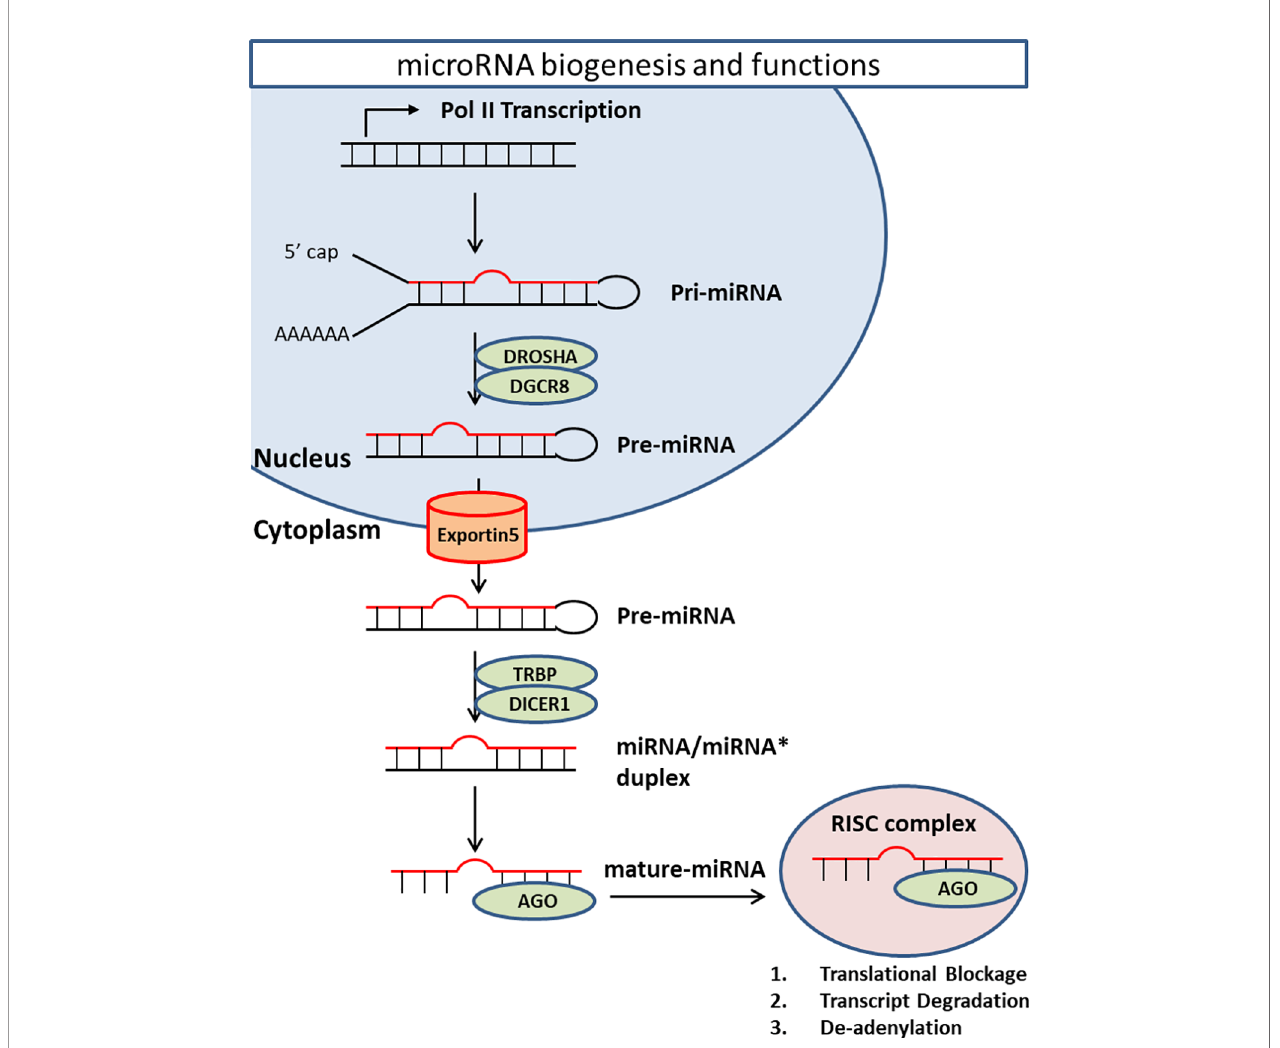
FIGURE 2 | MiRNA biogenesis and functions. Primary miRNA is transcribed from encoded gene. RNase III enzyme Drosha generates precursor miRNA by removing the fl anking segments and -11 bp stem region of pri-miRNA. Drosha requires DiGeorge syndrome critical region 8 (DGCR8) to complete this process. pre-miRNAs are then transported from nucleus to cytoplasm by a transporter Exportin-5 (XPO5) in a Ran-GTP-dependent manner. In the cytoplasm, Dicer converts pre-miRNA into double-strand mature miRNA. Dicer requires TAR RNA-binding protein (TRBP) as a cofactor. Finally, one strand of miRNA/miRNA* duplex loads onto Argonaute homolog protein (Ago) to make RNA-induced silencing complex (RISC). RISC/miRNA complex mainly works as suppressor of mRNA expression through translational blockage, transcript degradation, and